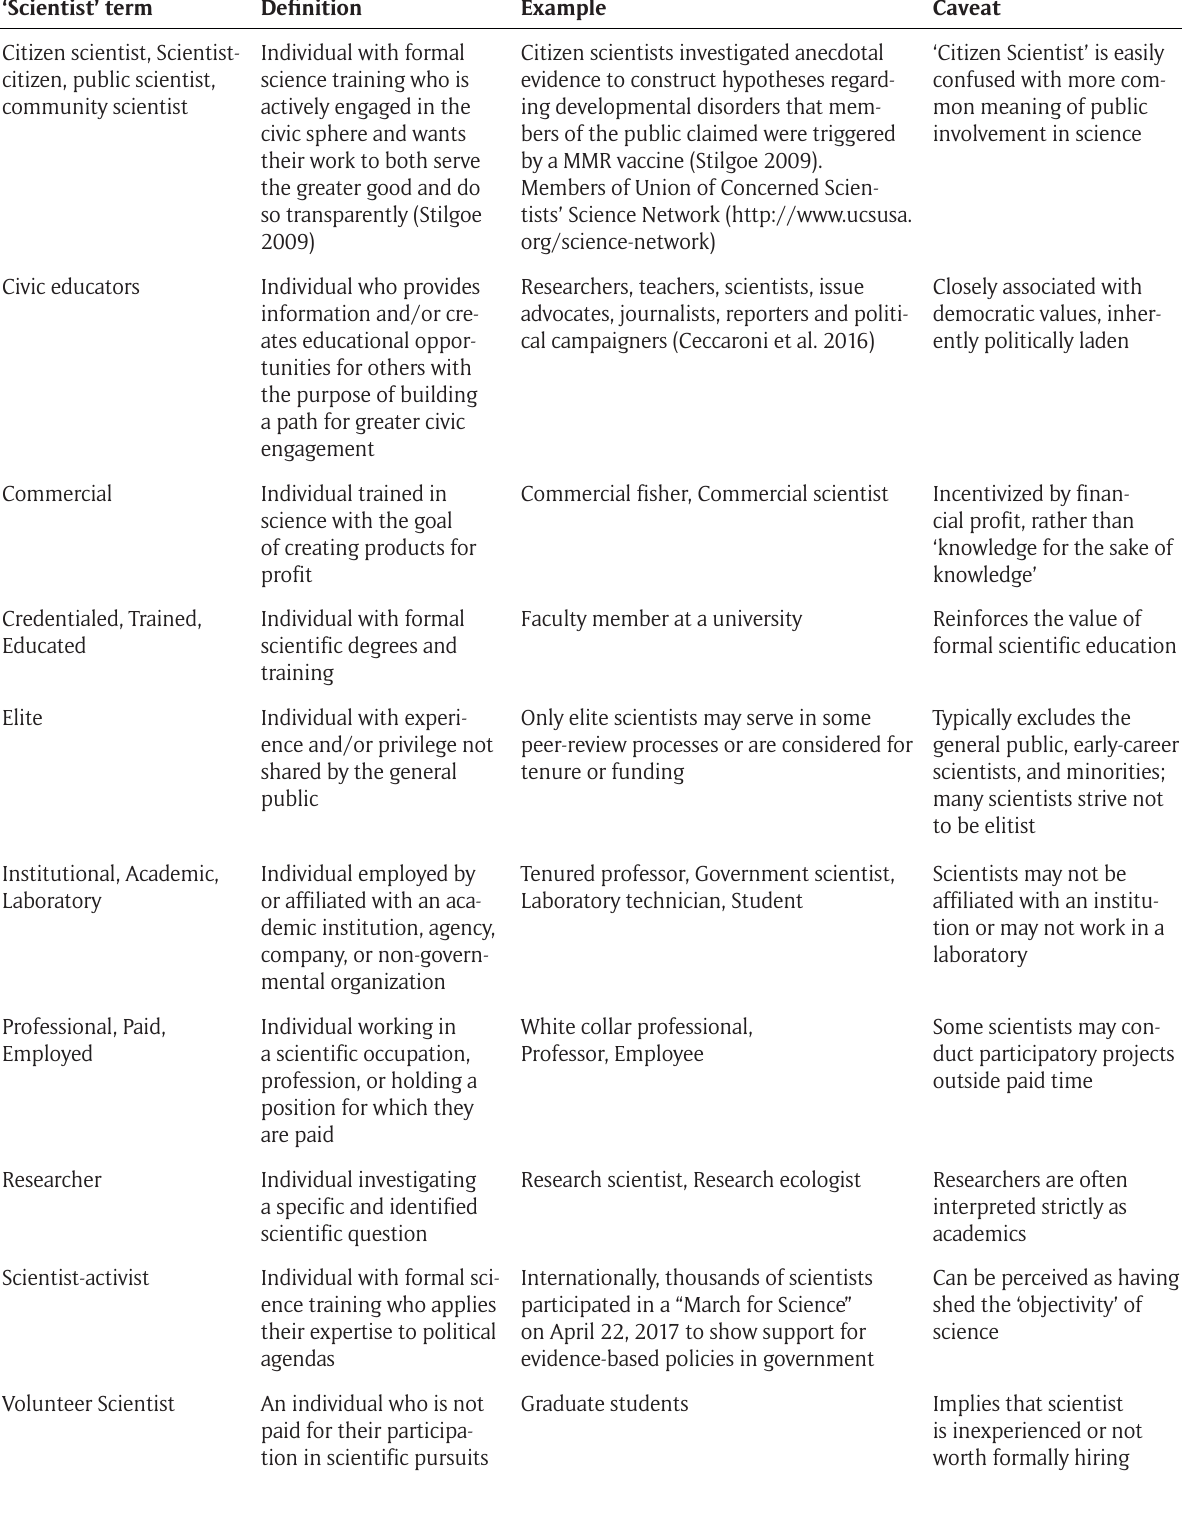
Table 3: Terms describing scientists who work with citizens in ‘citizen science.’ ‘Scientist’